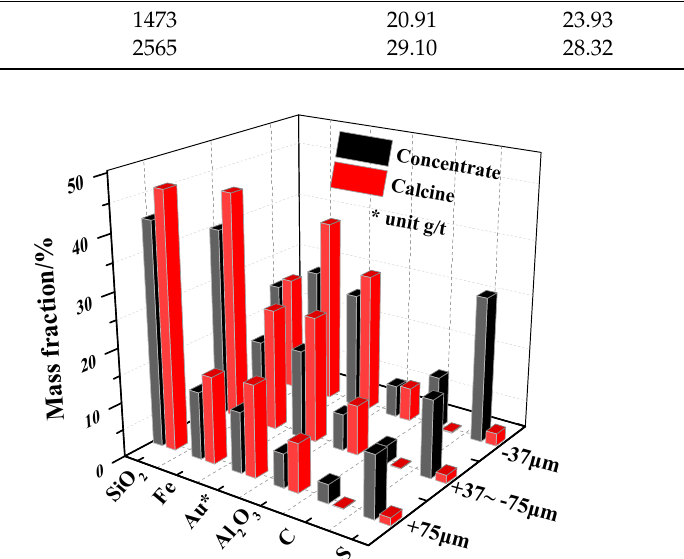
Table 4. The distribution and specific surface area of different size fractions/(mass fraction, %). Gold Ore Type